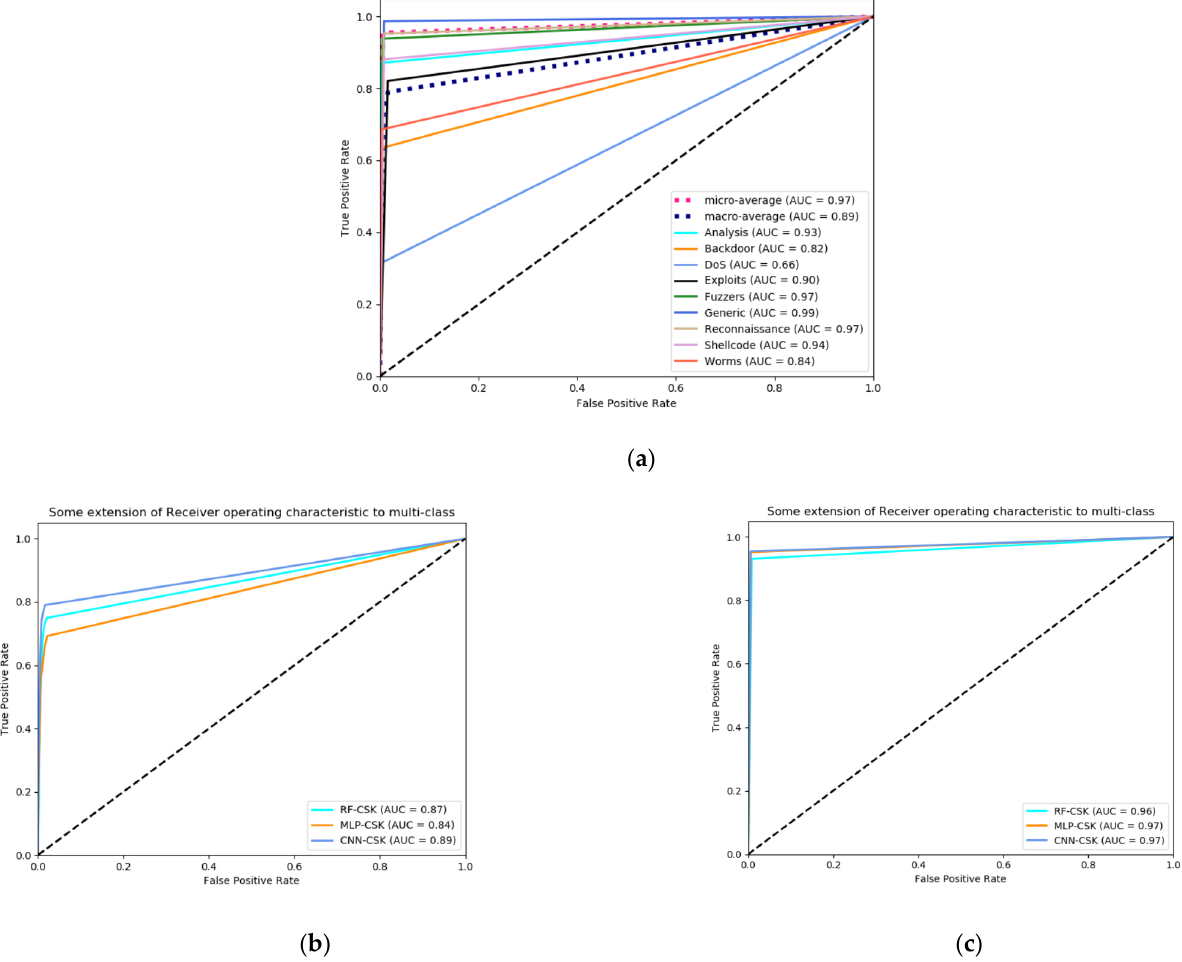
Figure 4. ROC curve of multi-classification for UNSW-NB15. ( a ) 9-class; ( b )macro; ( c )micro.